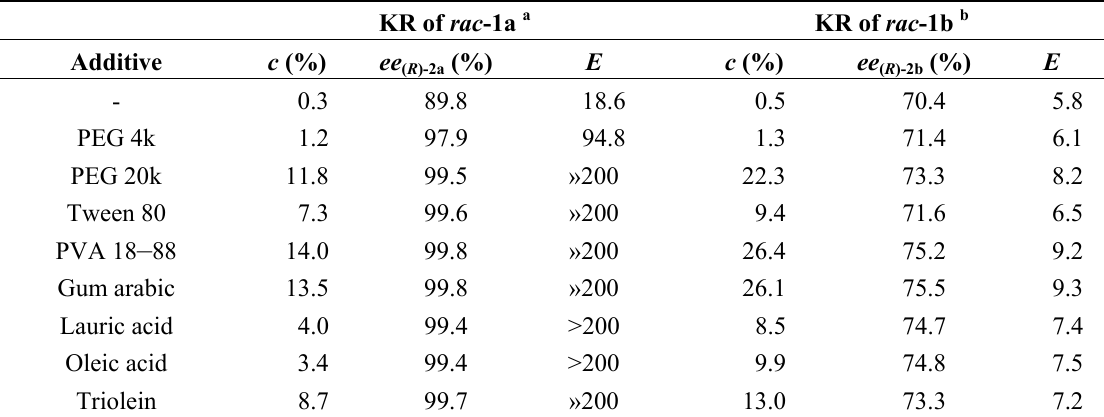
Table 2. Biocatalytic properties of Bc L covalently attached by GDE cross-linker onto mixed-function-grafted mesoporous silica gel in the kinetic resolution of rac -1a and rac -1b in batch